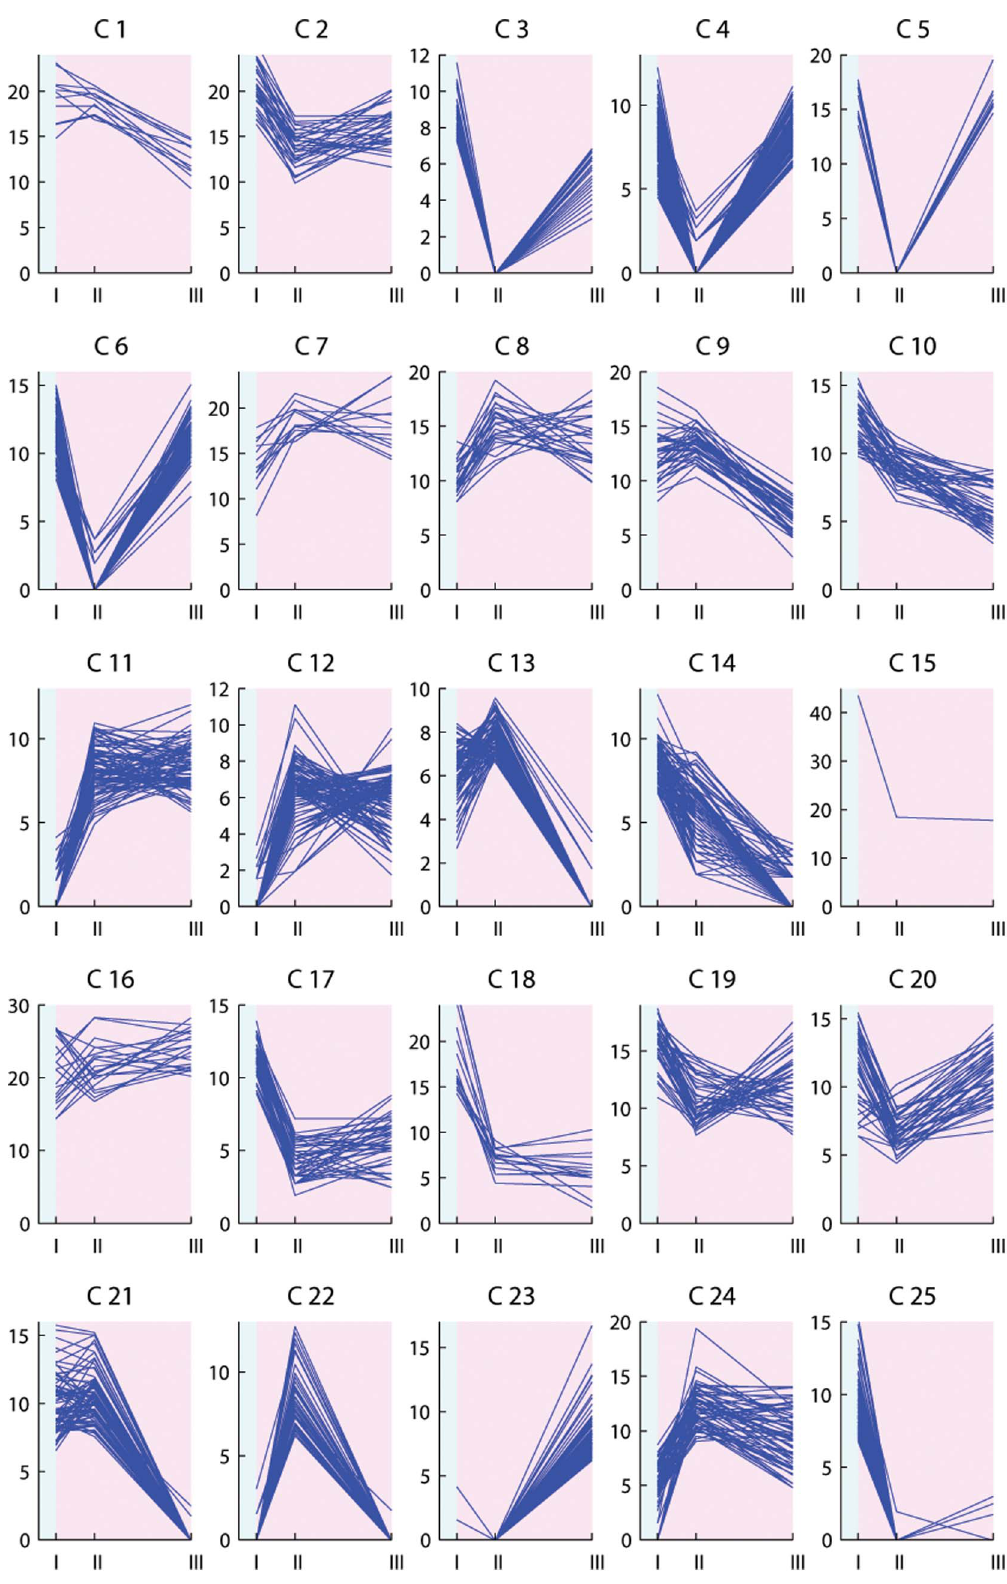
Figure 6. K-means clustering analysis of transcripts differentially expressed in Veyo enriched meristem samples. K=25 clusters. The x axis presents the sample collection time points: I=9 weeks of vernalization; II=1 long day; III=7 days of long day conditions. The y axis corresponds to the variance stabilized data from DESeq. The blue background illustrates vernalization treatment, the pink background illustrates long day conditions. doi:10.1371/journal.pone.0107365.g006 PLOS ONE |